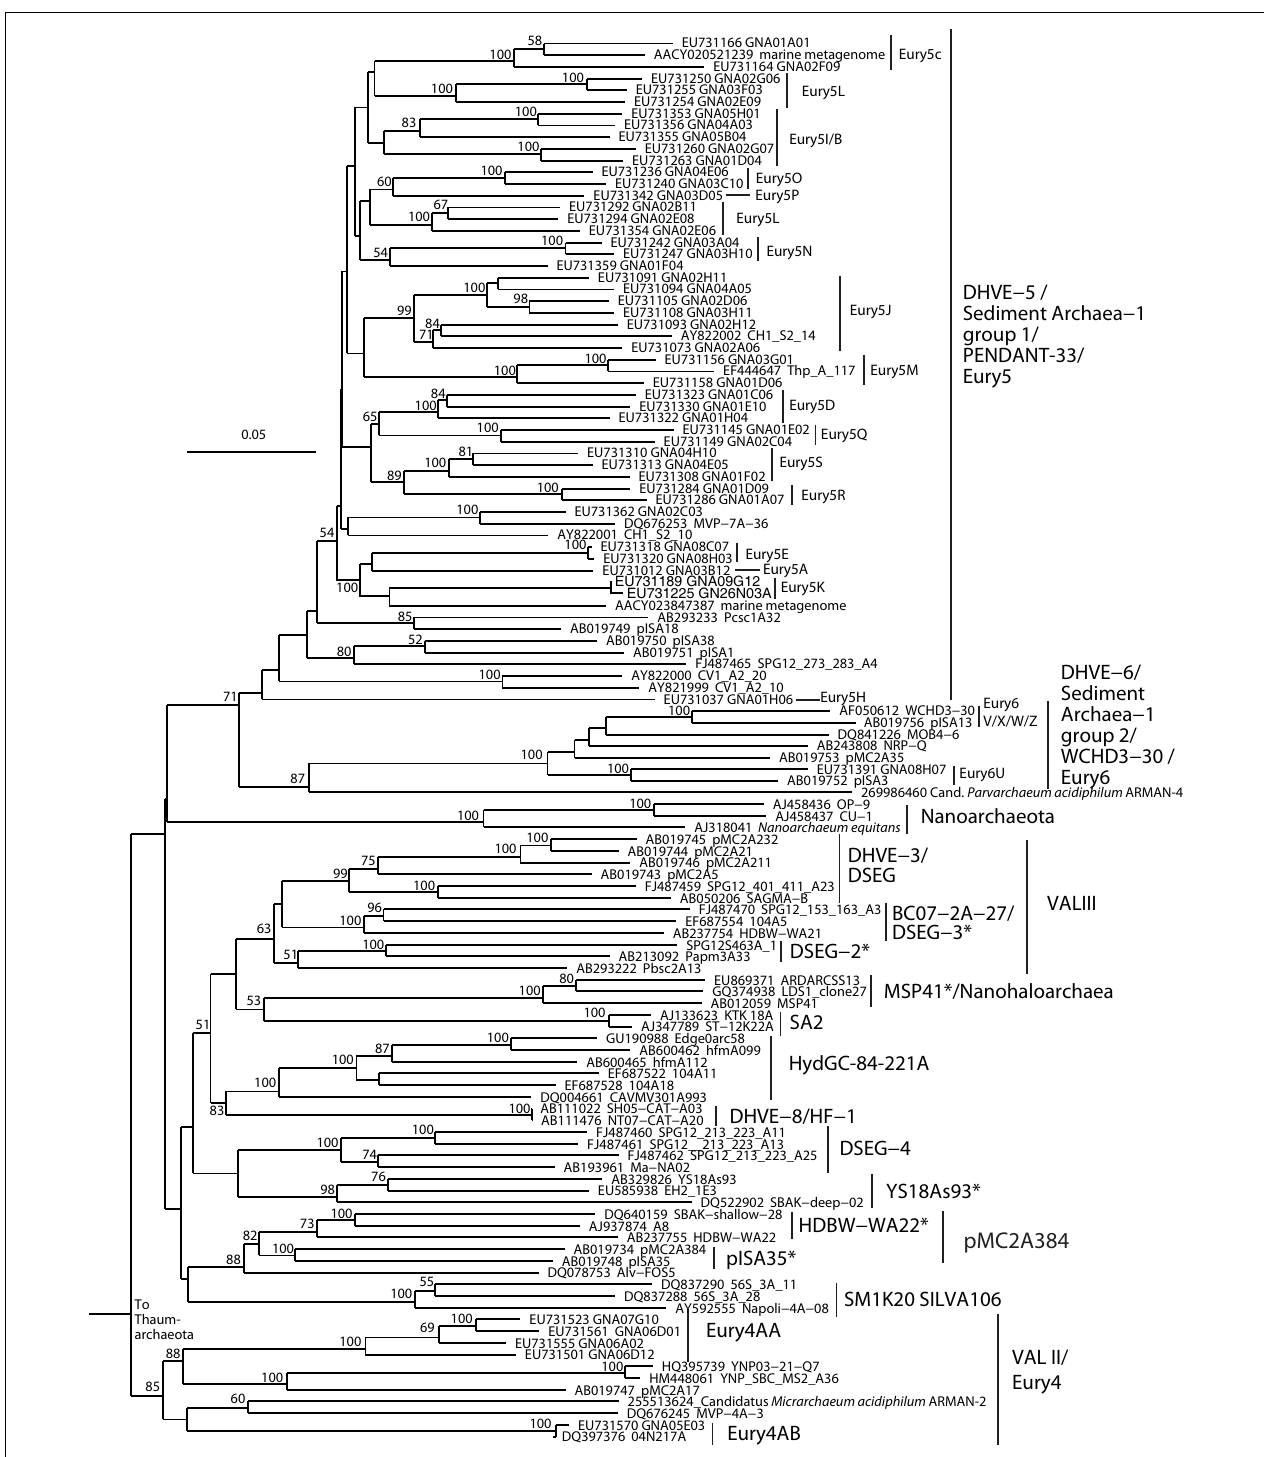
likelihood bootstrap replications inTreeFinder (Jobb et al., 2004). Branches are annotated with names and acronyms that are used in the literature ( Table 3 ). The archaeal taxa marked with asterisks are novel designations introduced either in Durbin andTeske, 2011 or in this study ( Table 3